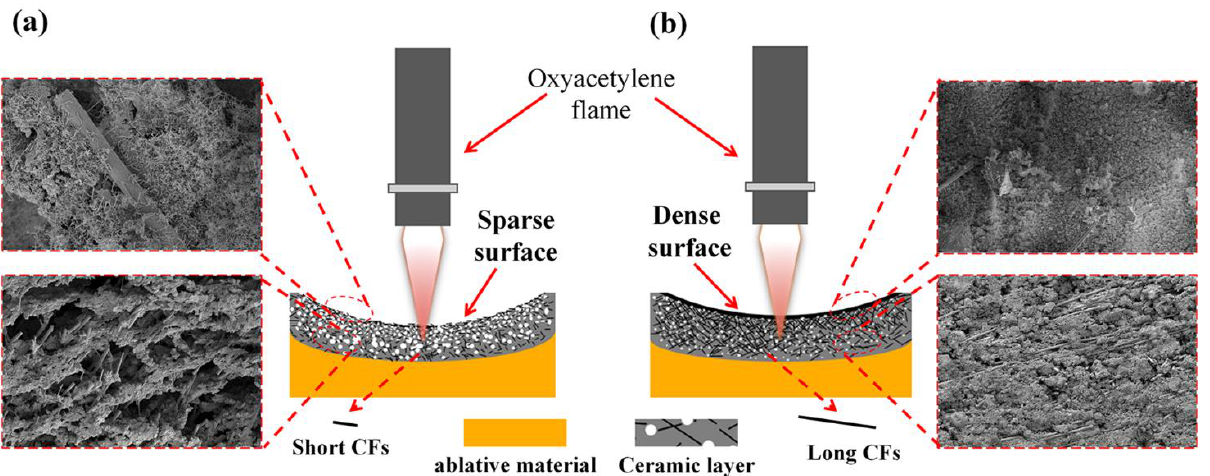
Figure 11. Ablation mechanism of CF-filled silicone rubber-based ablative composites: ( a ) short carbon fibers, ( b ) long carbon fibers.